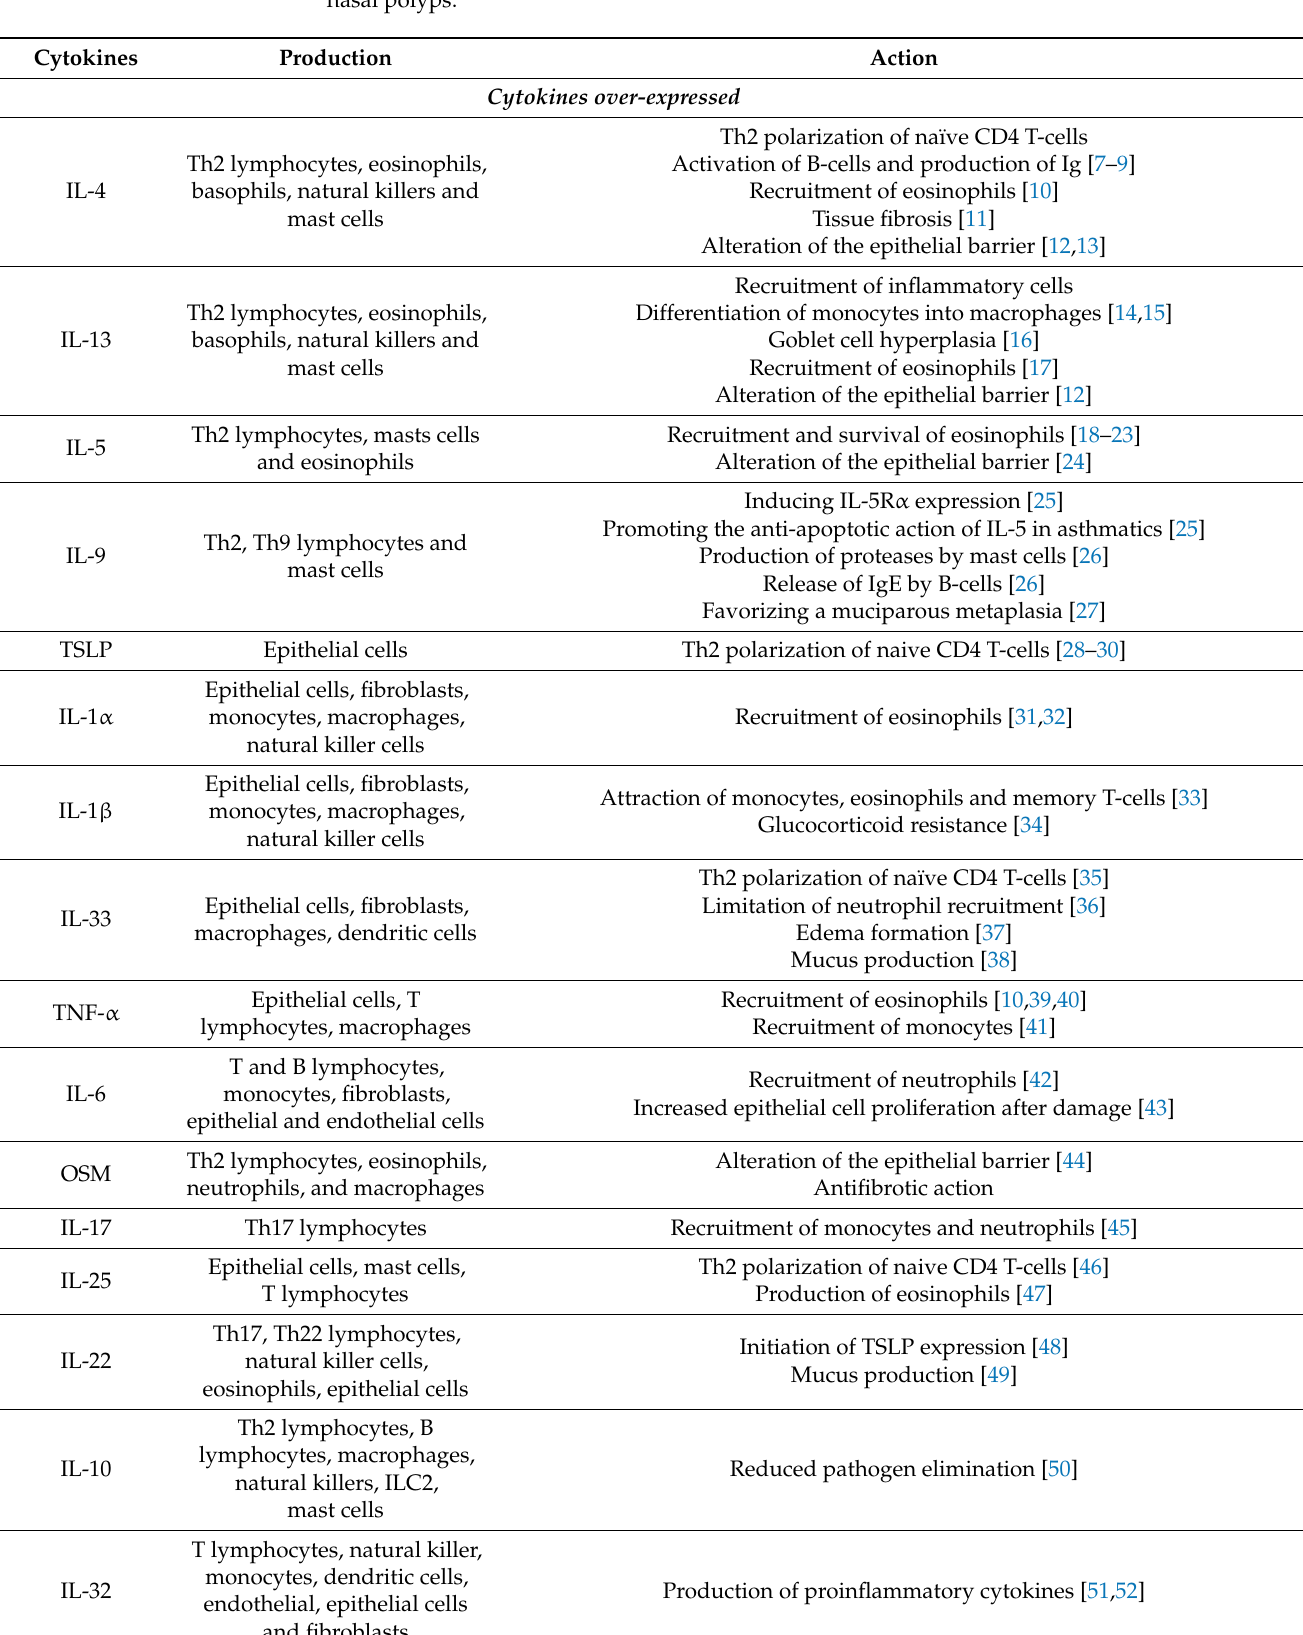
Table 1. Production and action of cytokines over and under-expressed in chronic rhinosinusitis with nasal